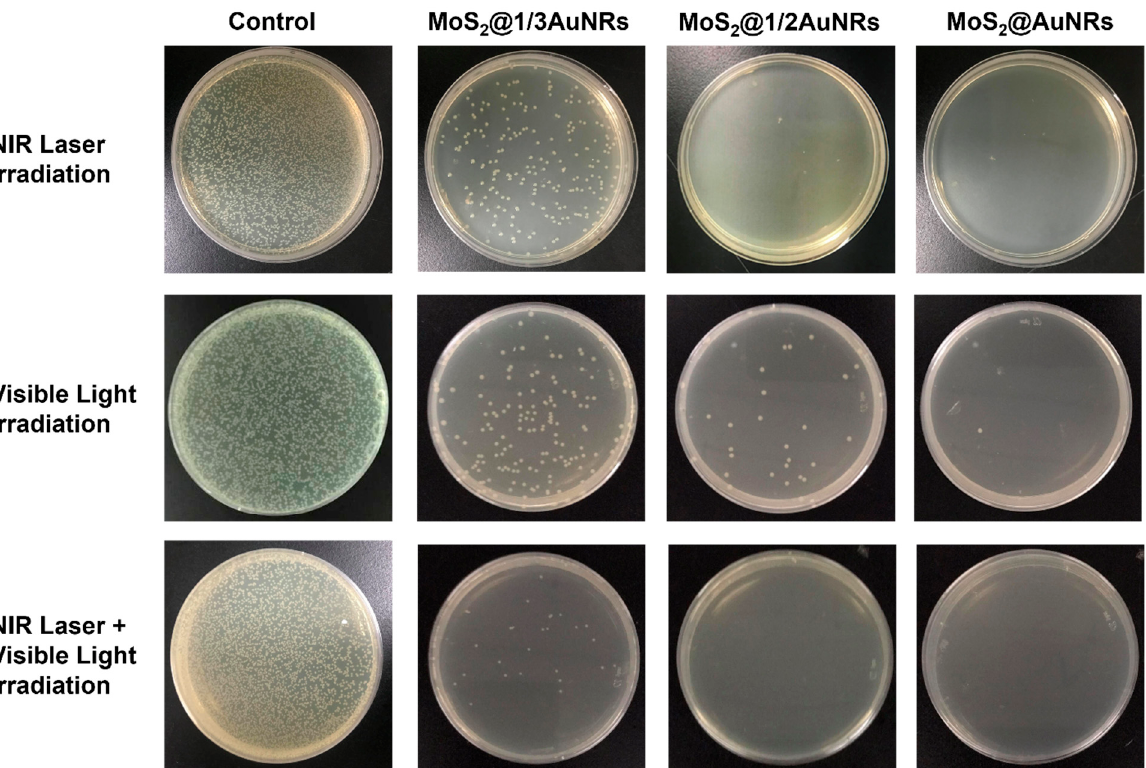
Figure 7. Photographs of the growth of Escherichia coli incubated with sterilized water (control) and molybdenum disulfide (MoS 2 )@1/3 gold nanorods (AuNRs), MoS 2 @1/2AuNRs, and MoS 2 @AuNRs on LB agar plates after NIR laser, visible light, or both NIR laser and visible light irradiation. The antibacterial rate of the control was set to 0% for each type of irradiation.